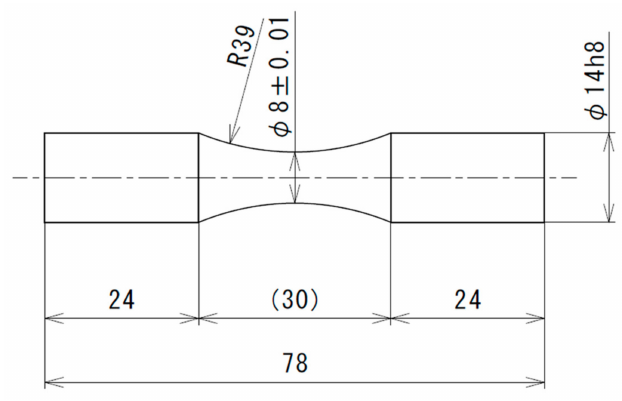
Figure 8. Specimen geometry (mm).